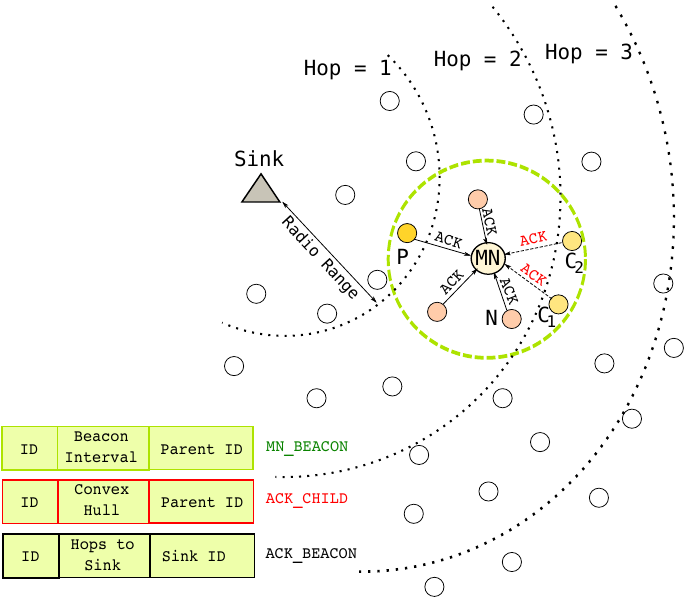
Figure 4. Beaconing to handle mobility of MN in the routing